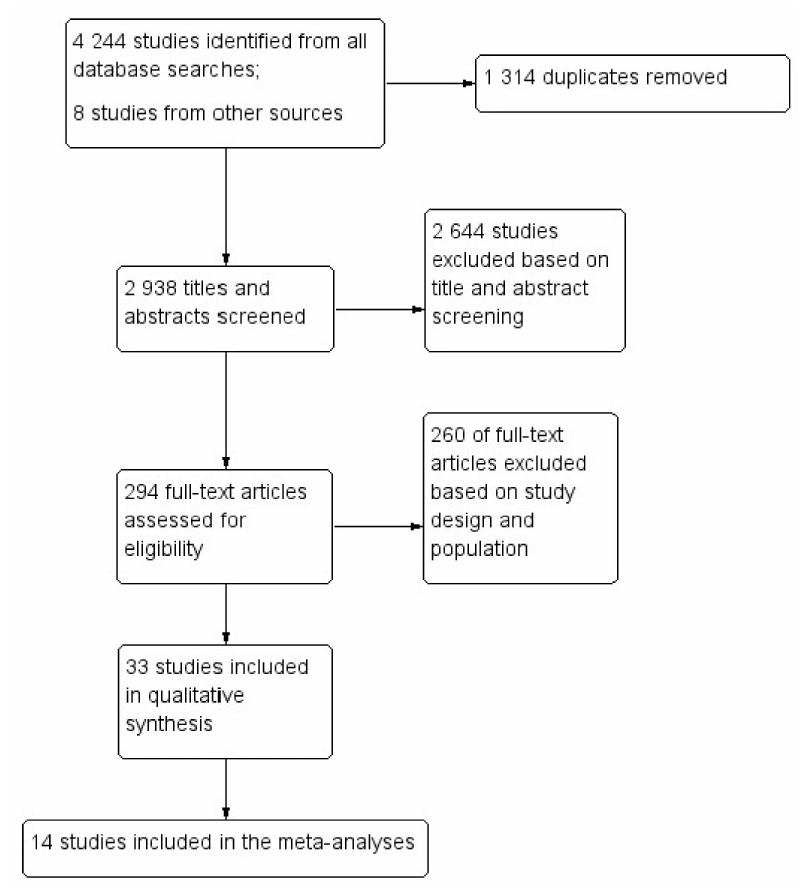
Figure 1. Flow diagram for the selection of